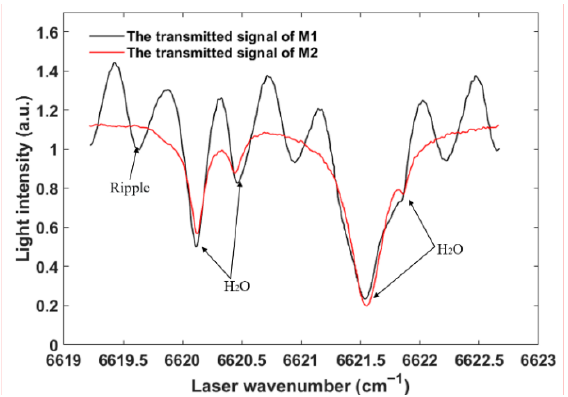
Figure 2. The normalized OF-CEAS transmitted light signal detected at M1 (black) and M2 (red). The spectrum detected at M1 presents a periodic spectrum fluctuation including four absorption lines. The spectrum detected at M2 only has four absorption lines.